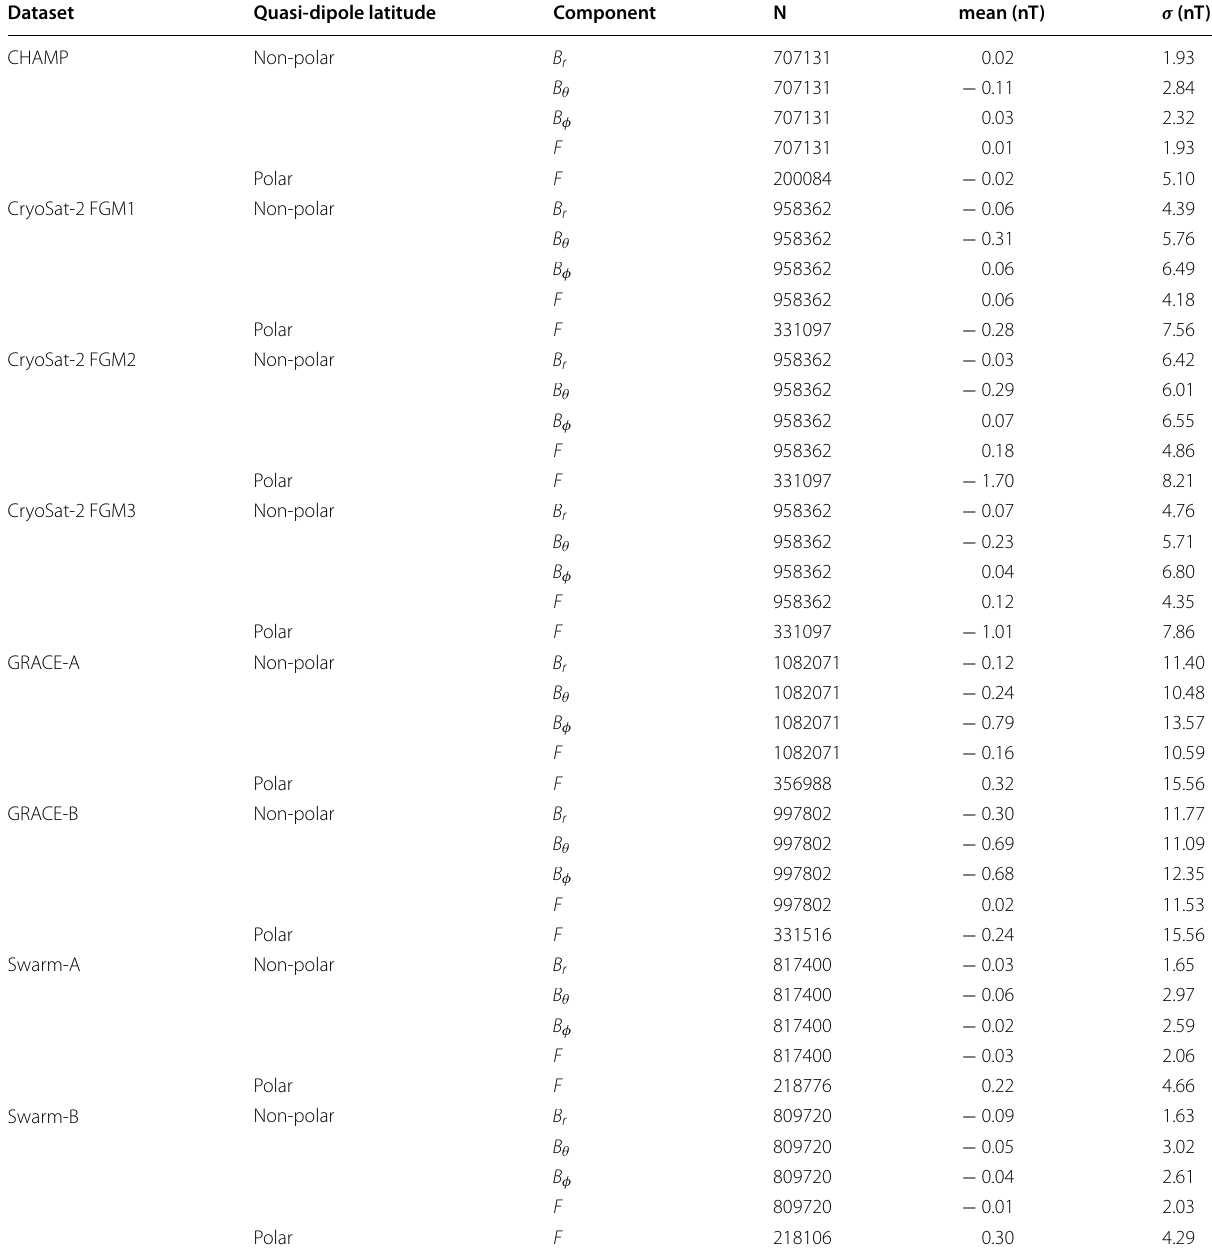
Table 5 Number N , Huber-weighted mean, and standard deviation σ computed from the residuals of the satellite data for each vector component and split into polar (poleward ± 55 ◦ ) and non-polar (equatorward ± 55 ◦ ) QD latitudes. Note that non-polar scalar data were not used in the model parameter estimation—statistics are only shown for completeness